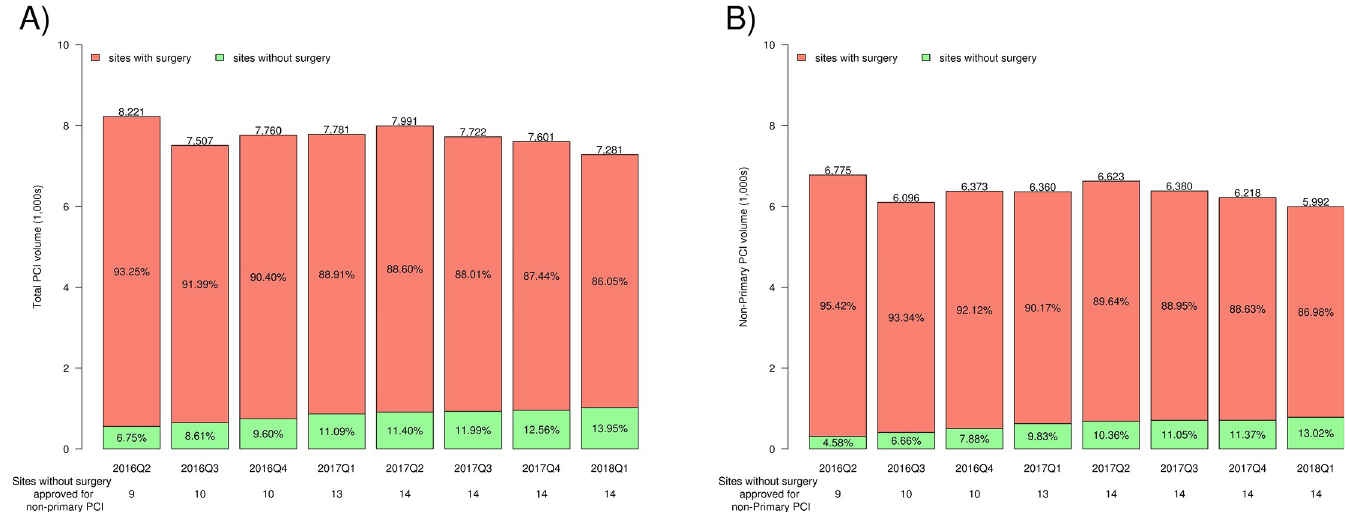
Fig 2. Trends of PCI performed in Michigan during study period. Trends and site-specific distribution of (A) all PCIs performed in Michigan, and (B) non-primary PCI cases, during the study period as demonstrated in a quarterly fashion. Number of participating sites without cardiac surgery on-site per quarter displayed below each